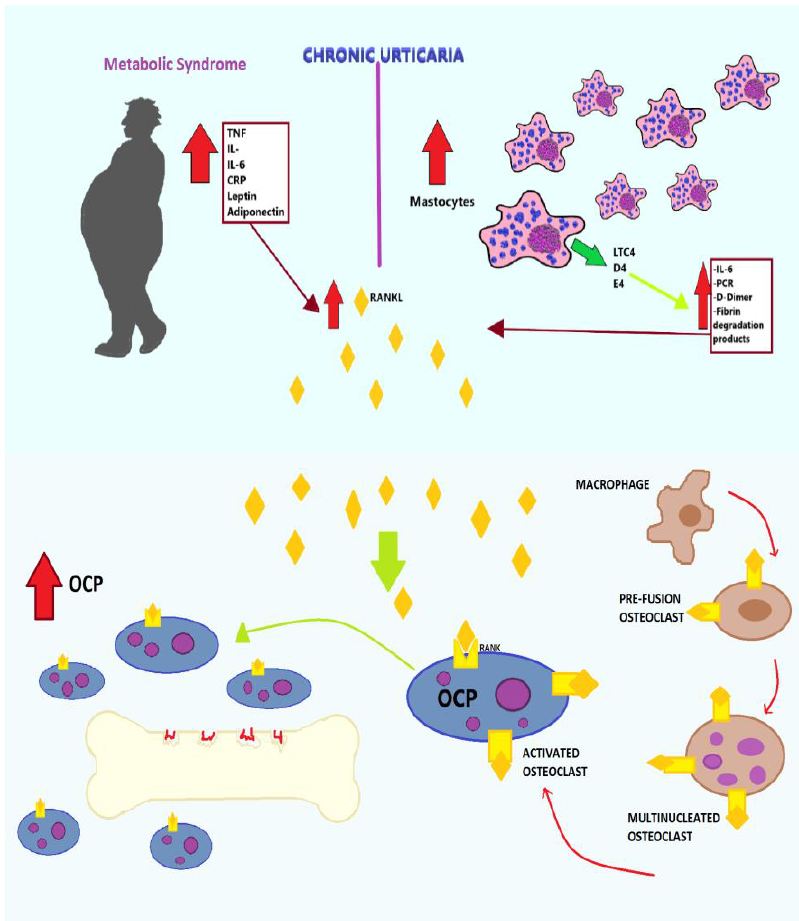
Figure 4. Mechanisms underlying bone resorption in patients with chronic urticaria (CU). Increased cytokines (TNF- α , IL-1 β , IL-6, C-reactive protein (CRP), leptin, adiponectin) in metabolic syndrome and mediators produced by mast cells (IL-6, PCR, D-dimer, fibrin, degranulation products) lead to the activation of RANKL, which promotes the differentiation of macrophages in pre-fusion osteoclasts, then in multinucleated osteoclasts, and finally in activated osteoclasts, increasing bone resorption.